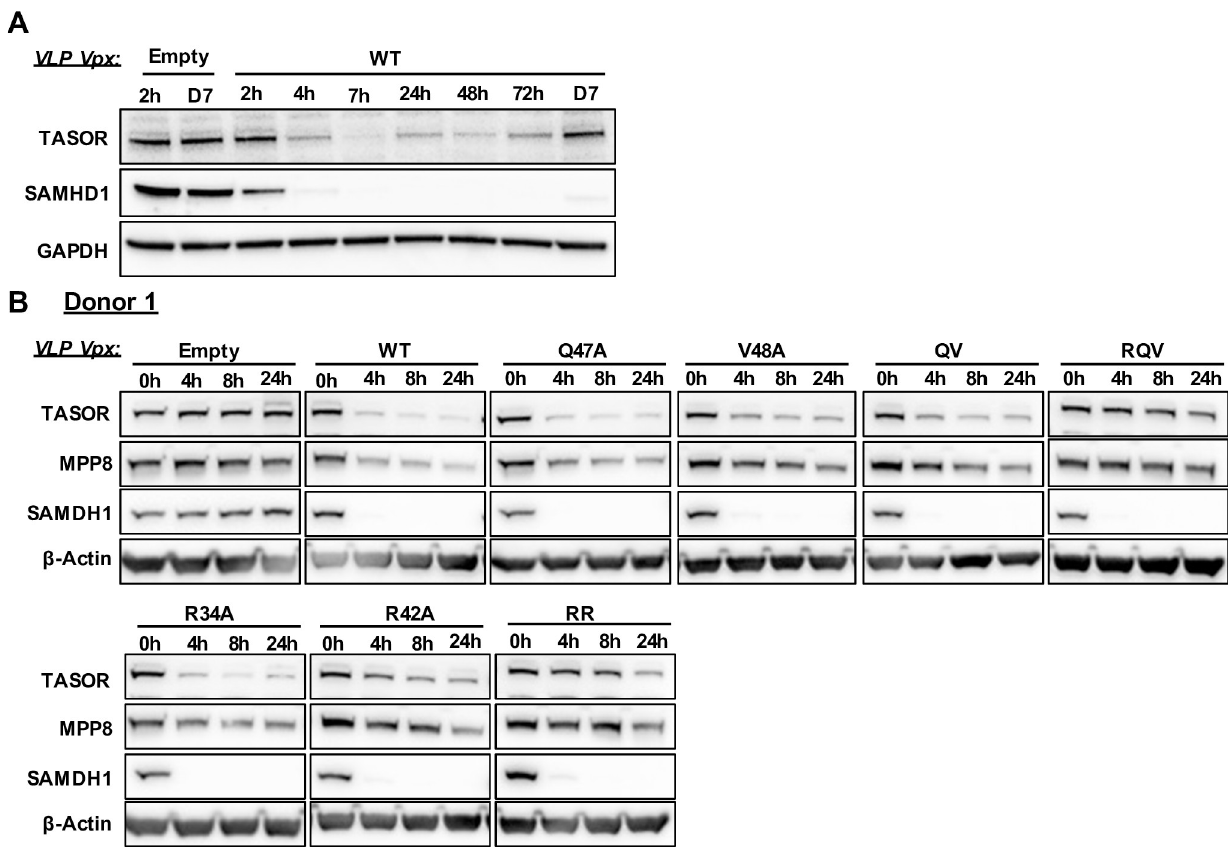
Fig 6. Vpx R34A-R42A and Vpx R42A-Q47A-V48A mutants are impaired in inducing TASOR, but not SAMHD1, degradation in macrophages. Long ( A ) and short ( B ) kinetics of TASOR and SAMHD1 degradations by HIV-2.Gh1 Vpx WT or mutants brought by VLP in Monocyte-derived- Macrophages (MDM). Purified monocytes from an healthy donor were differenced 7 days with GM-CSF and M-CSF. After differentiation, MDM were transduced with indicated Vpx-containing VLPs and harvested at indicated times. Whole cell extracts were analyzed by western-blot. QV ; Vpx Q47A-V48A double mutant. RQV : Vpx R42A-Q47A-V48A triple mutant. RR : Vpx R34A-R42A double mutant. For this figure, TASOR and SAMHD1 degradation were tested in tree independent donors ( see S7 Fig